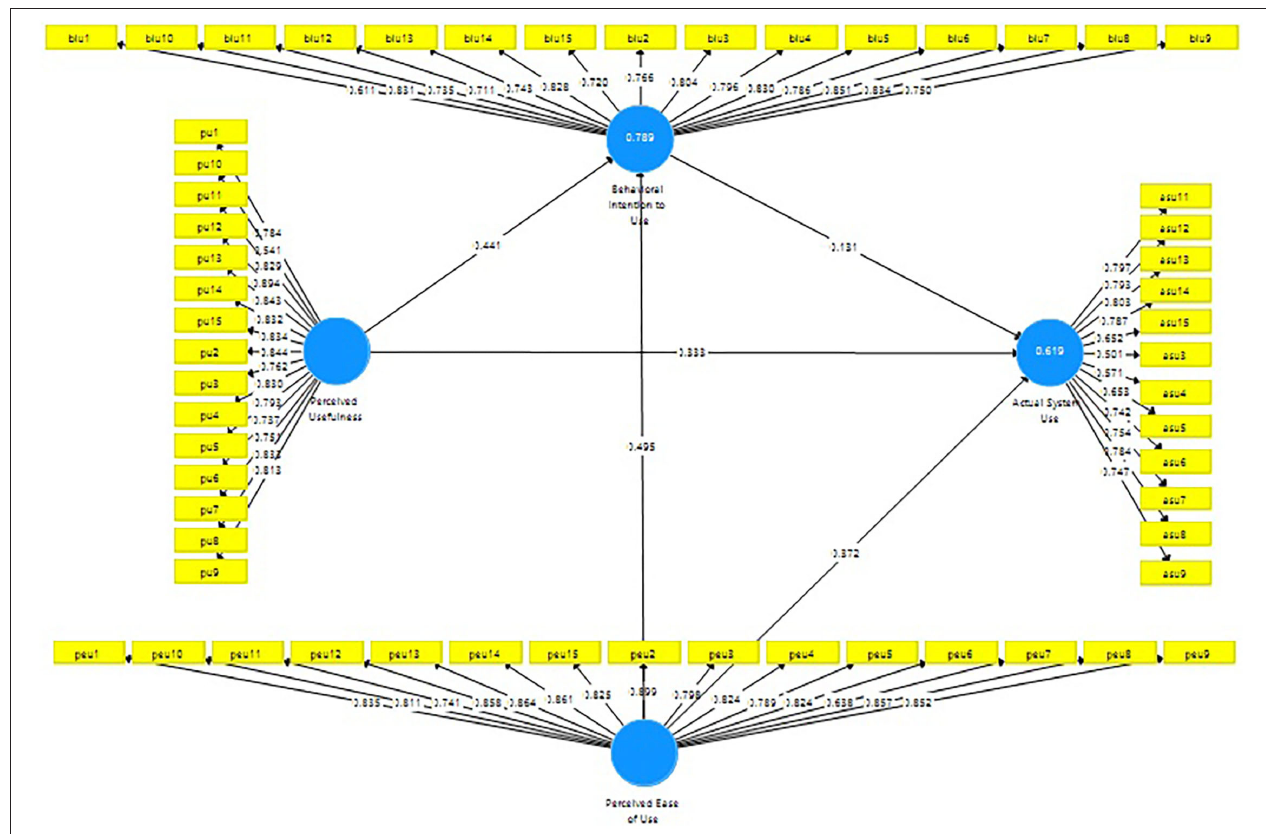
FIGURE 2 | Convergent validity